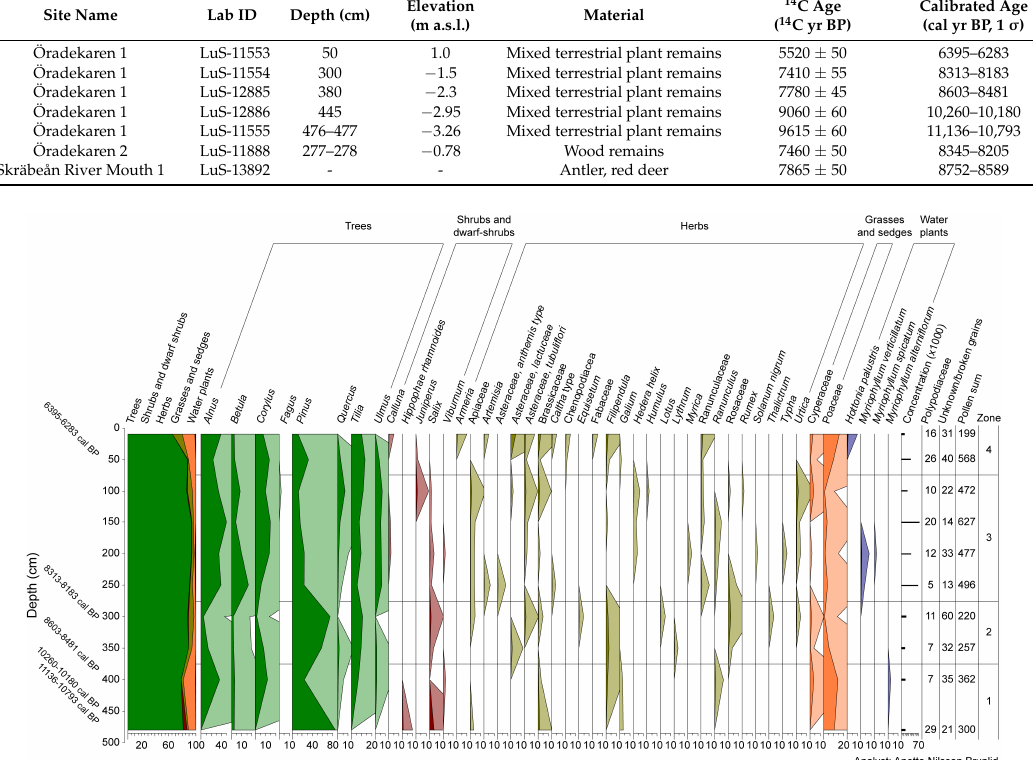
Figure 5. Pollen percentage diagram for the Öradekaren 1 sequence. The recorded taxa are divided into five groups: trees, shrubs and dwarf-shrubs, herbs, grasses and sedges and water plants. The pollen record is divided into four pollen assemblage zones based on marked